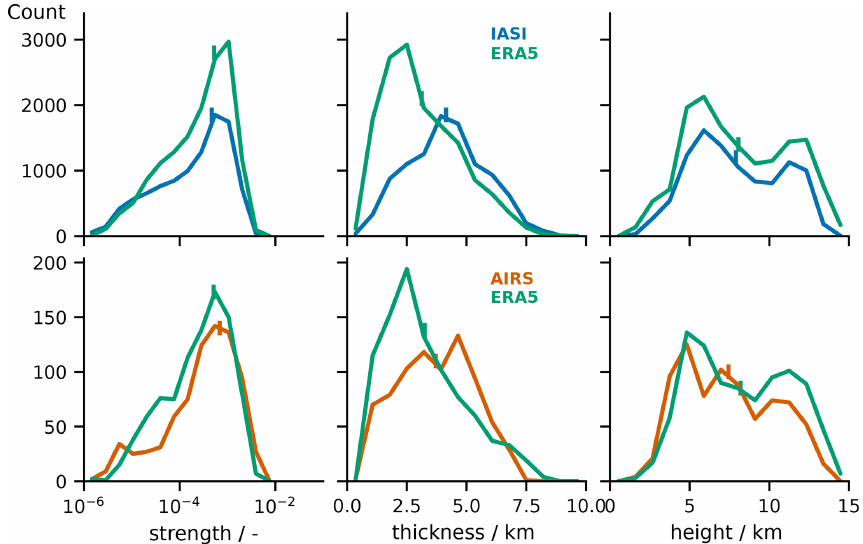
Figure 6. Same as Fig. 4 but with cloud fraction < 0 . 2 in AIRS and IASI datasets. Collocations with reference to GRUAN are omitted due to limited clear-sky sampling. Vertical dashes indicate the